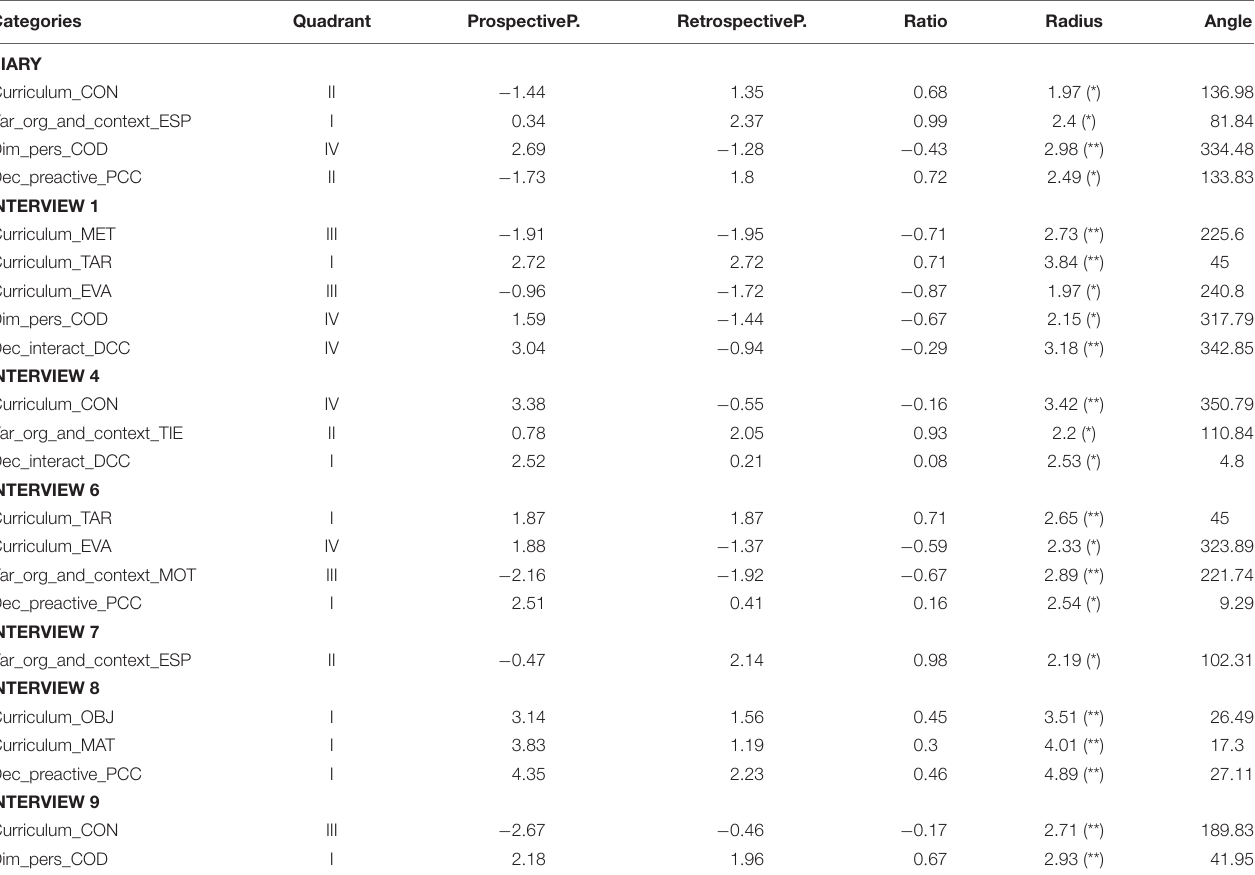
TABLE 3 | Relationships between the TAR category and the rest of the categories in the diary and interviews of Maria. Categories Quadrant ProspectiveP. RetrospectiveP. Ratio Radius